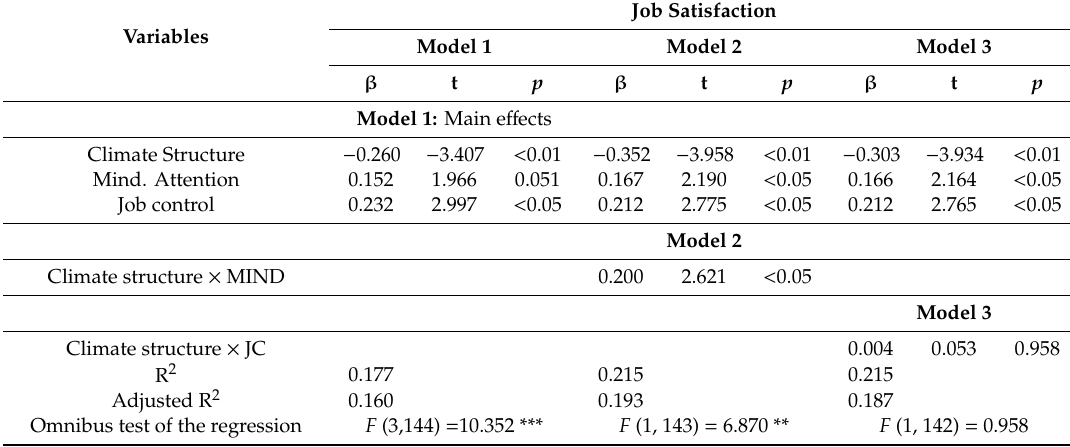
Table 5. Hierarchical regression analyses of the independent and interactive associations of sources of stress (FS—Climate, Organizational), mindfulness attention, and job control (JC) with job satisfaction (using 1000 bootstraps) ( n = 148).